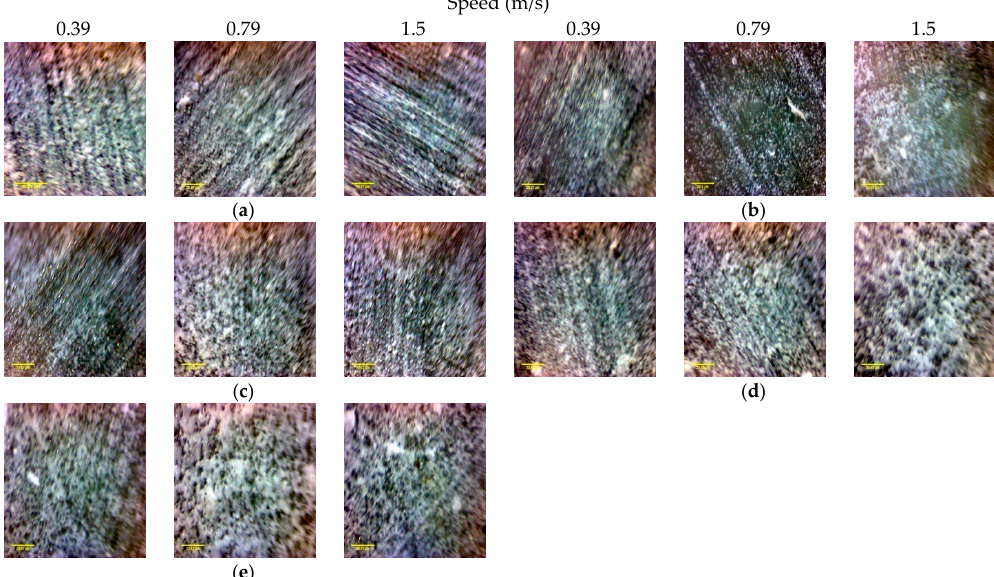
Figure 11. The optical micrographs of the surface of the sample before and after wear tests: ( a , b ) M 1 , ( c , d ) M 2 , ( e ,f) M 3 , ( g , h ) M 4 , and ( i , j ) M 5 . in a rougher surface.